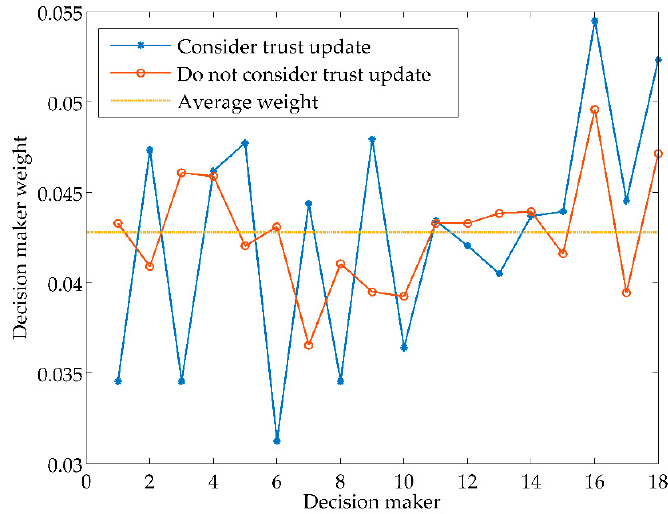
Figure 5. The influence of trust updating on the weight of decision makers.